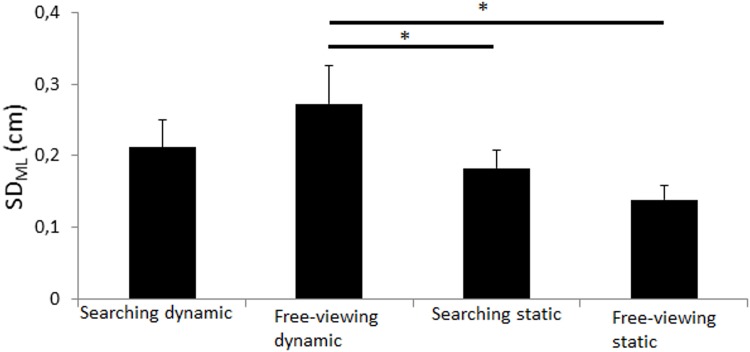
Standard deviation in medio-lateral.Standard deviation in medio-lateral (in cm) in both searching task (static and dynamic) and in both free-viewing task (static and dynamic). Vertical bars indicate the standard error. Horizontal bars indicate significant interactions.